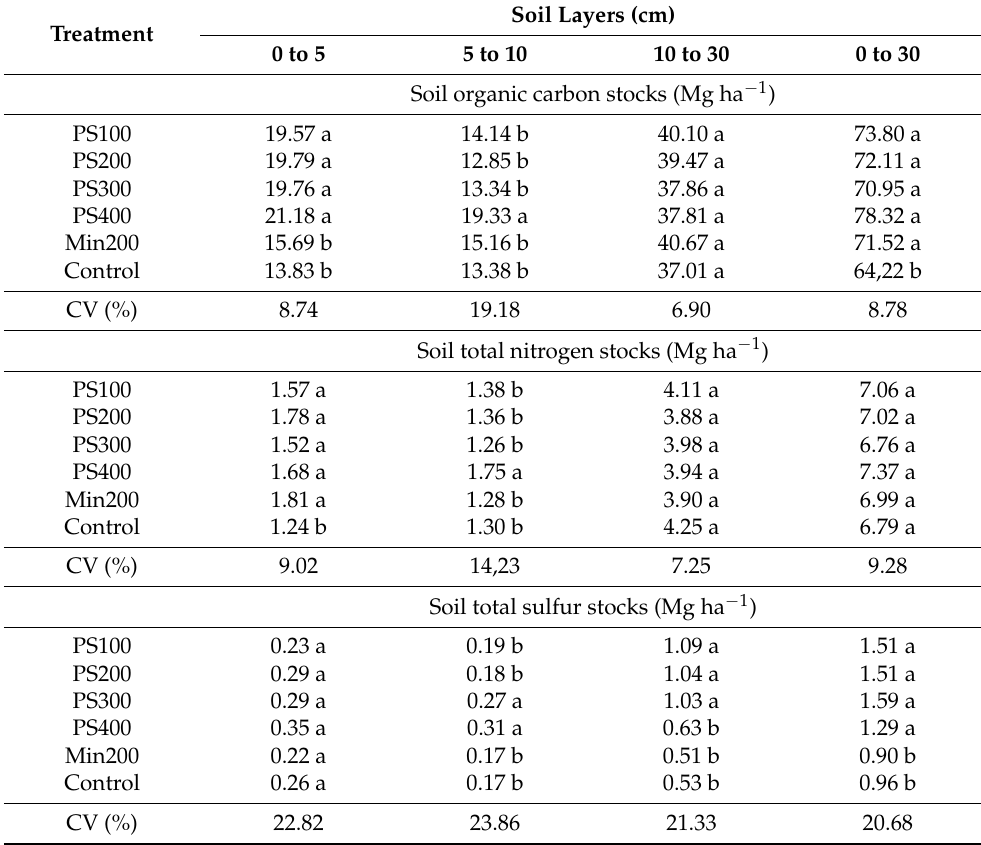
Table 5. Soil carbon, nitrogen, and sulfur stocks after application of organic (pig slurry; PS) and mineral (urea; Min200) fertilizers. Ibirub á , Rio Grande do Sul, Brazil.